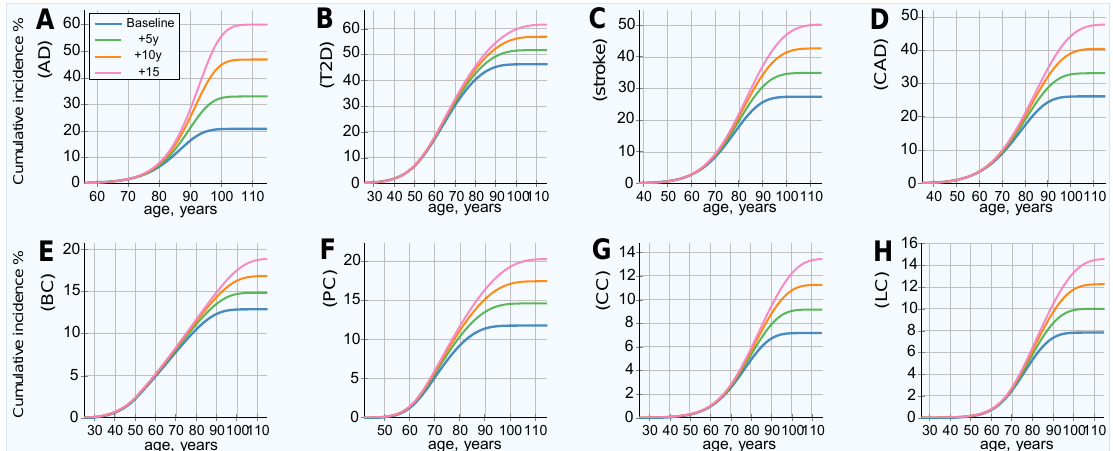
Figure 2. Projected LOD cumulative incidence and lifetime risk increase for life expectancy increases of 5, 10, and 15 years (baseline without gene therapy). ( A ) Alzheimer’s disease, ( B ) type 2 diabetes, ( C ) cerebral stroke, ( D ) coronary artery disease, ( E ) breast cancer, ( F ) prostate cancer, ( G ) colorectal cancer, and ( H ) lung cancer. This is the baseline scenario, without gene therapy or other health improvements for the plotted LOD. It represents the case where life expectancy increases due to causes other than the plotted LOD. Lifetime risk (lifetime cumulative incidence) corresponds to the lifetime (rightmost) values of the plots.